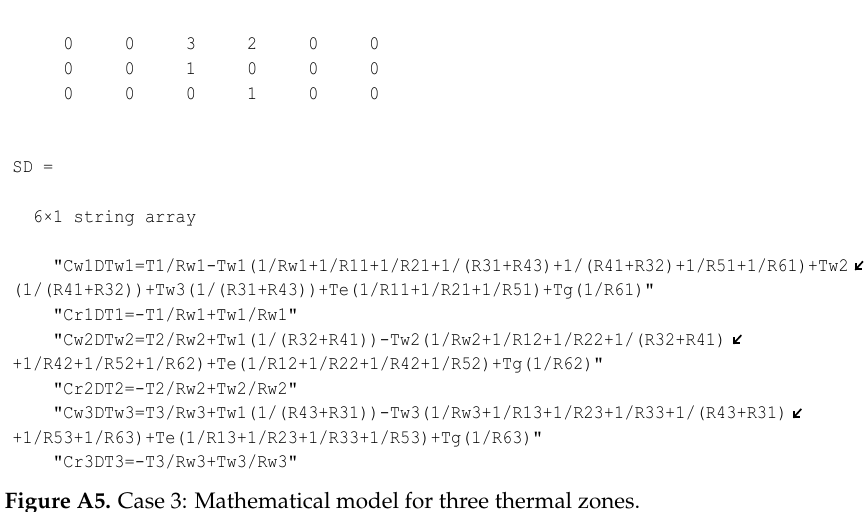
>> Figure A4. Case 2: Mathematical model for a double thermal zone.